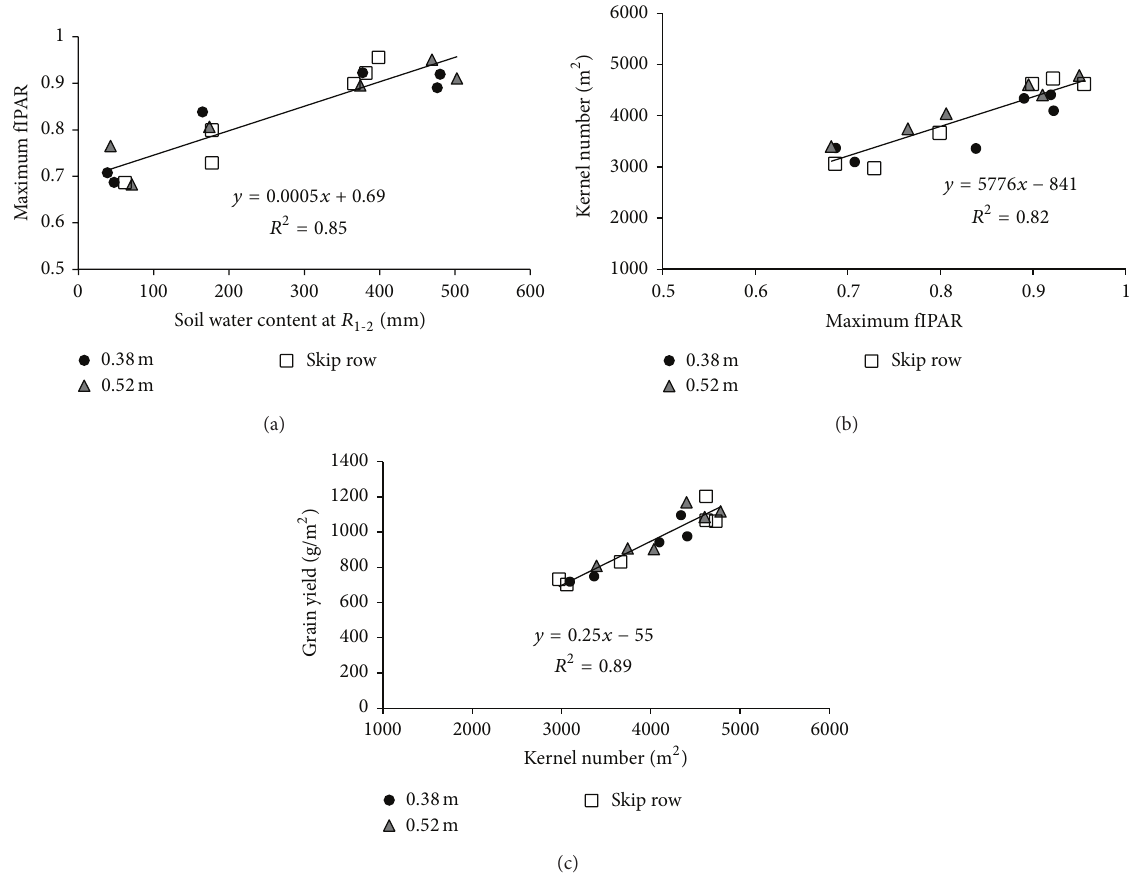
Figure 3: Maximum fraction of incident PAR intercepted (fIPAR) by crops as a function of soil water content (0–200 cm depth) close to silking (a), kernel number as a function of maximum fIPAR (b), and grain yield as function of kernel number (c) of maize crops cultivated at three landscape positions with three row spacings (0.38 m, 0.52 m, and 0.38 m in a 2 × 1 skip-row pattern) during 2006/07 and 2007/08. Values are the mean of three plots at each row spacing x landscape position. Lines indicate the models fitted to data